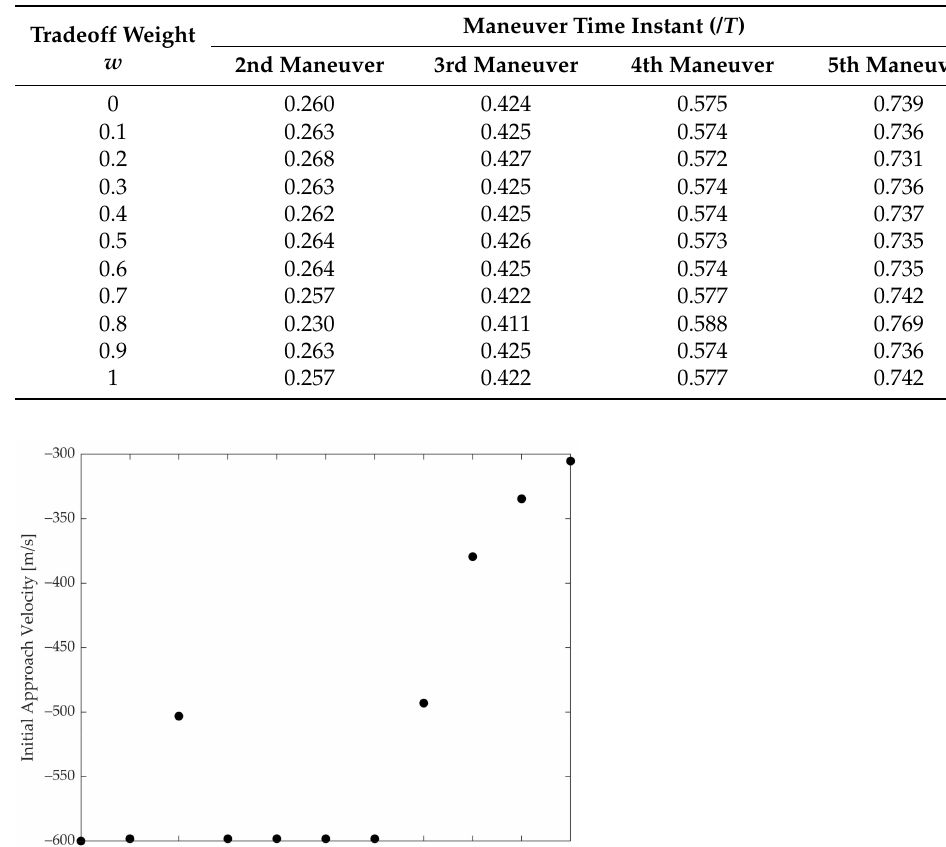
Table 3. Distributions of the time instants of dv s along the optimal trajectories with different w .